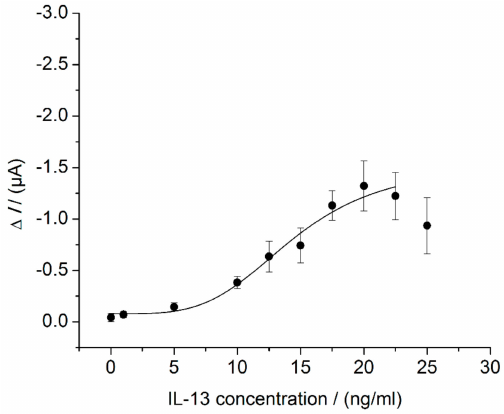
Figure 4. Characterization of the electrochemical IL-13 immunosensor in the beaker. Three different immunosensors prepared in the same manner (triplicates) for each concentration. Amperometric measurements performed at 0.0 V. Measurement in 10 mL of 1 mM hydroquinone in 0.1 M PBS pH 6 with 100 µ L of 50 mM hydrogen peroxide in 0.1 M PBS pH 6 added to start read-out. Measurements at 25 ng/mL of IL-13 are not included in curve